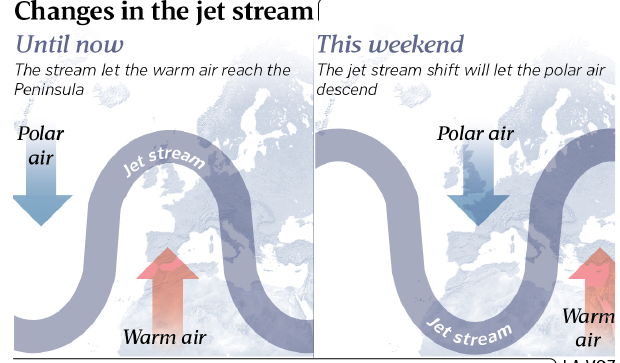
Figure 5. This image shows a practical example of the effects of jet stream weakening on a specific region of the Northern Hemi- sphere, such as Spain. In addition to generating adverse conditions, the weather can change from one extreme to another in a short time depending on the movements of the jet stream. In this case, as the figure shows, over the period of a few days, the positive thermal anomalies, due to the arrival of warm air, became negative due to the irruption of polar